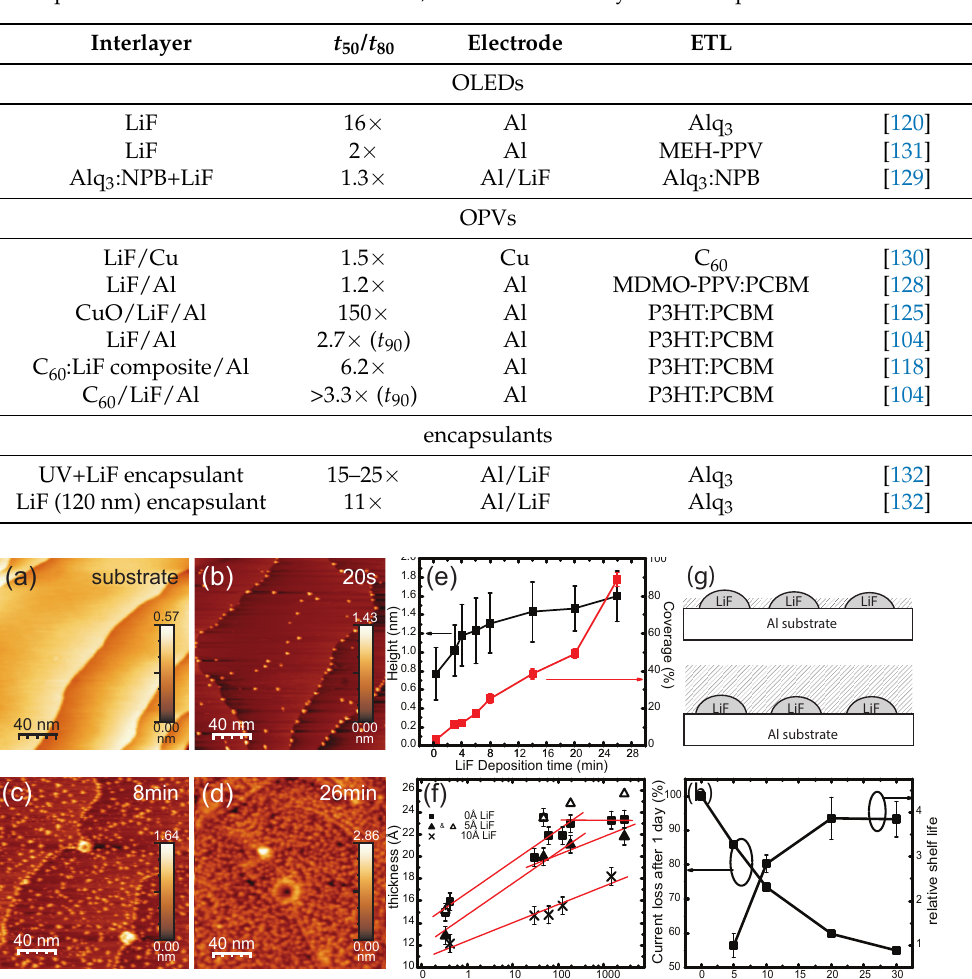
Table 1. Best improvement in the device lifetime, t 50 (for OLEDs) and t 80 (for OPVs) for LiF used at the top electrode relative to without its use, either as an interlay or an encapsulant.